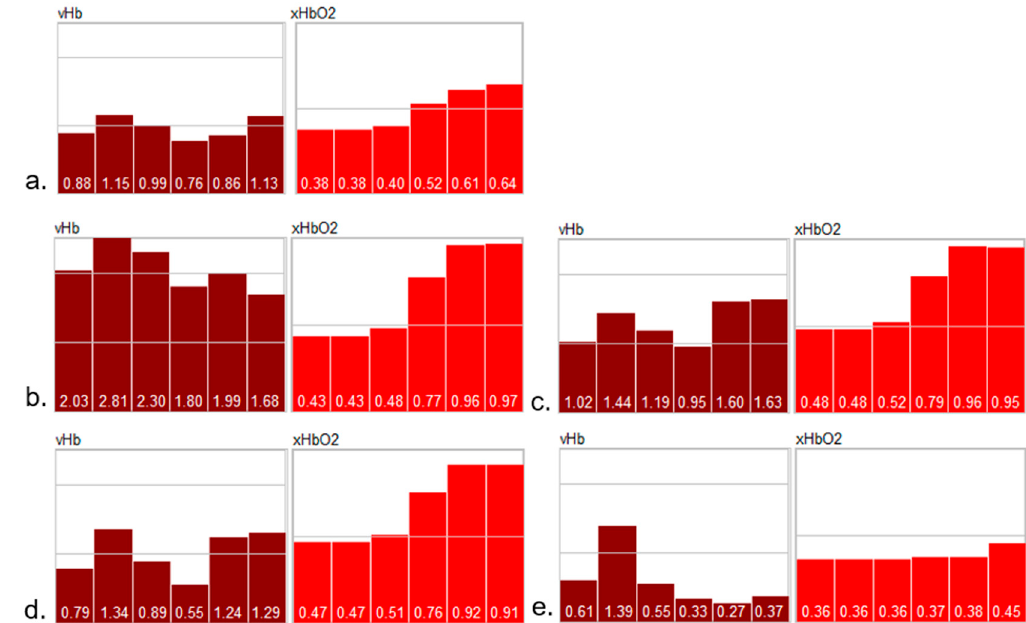
Figure 6. Depth profiles vHb, xHbO 2 for normal skin ( a ) and different burn degrees ( b ) superficial, ( c ) intermediate (superficial/partial), ( d ) partial-thickness, ( e ) full-thickness).